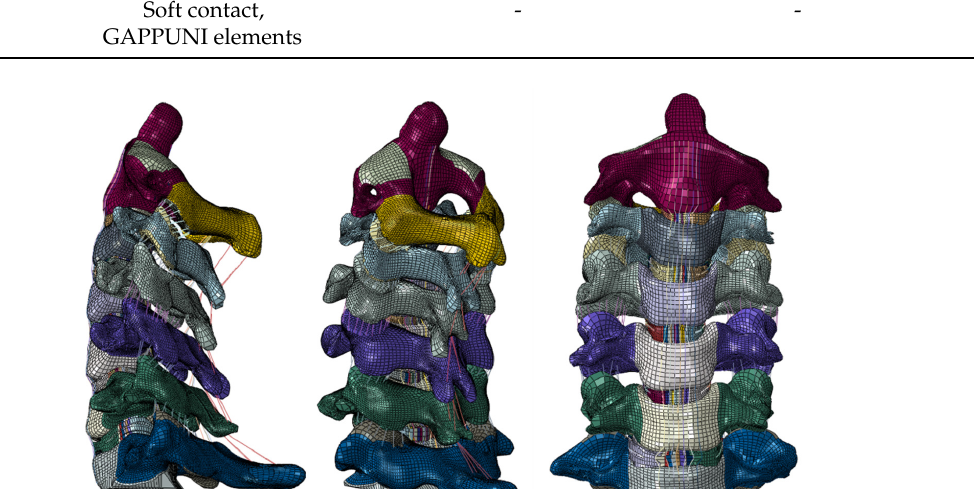
Figure 1. The intact (C2–C7) finite element model.